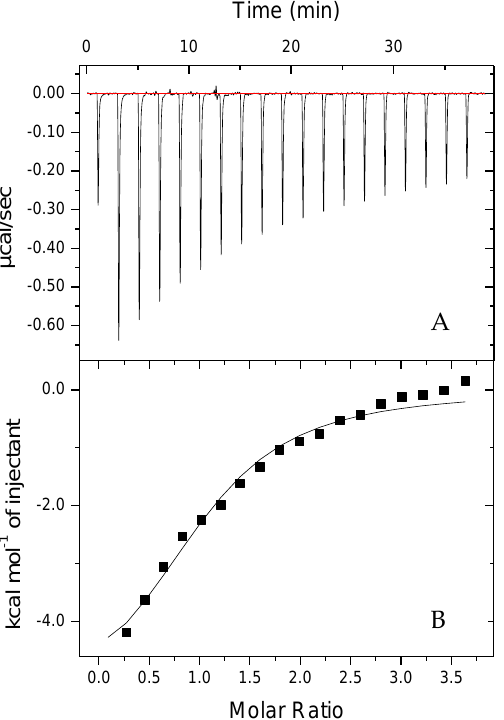
Figure 2. Calorimetric titration of SA (500 µM) with BSA (27 µM) at 25 °C, pH 7.4, raw data ( A ), integrated data, and fit (solid line) of the binding isotherm by the independent binding sites model ( B ).